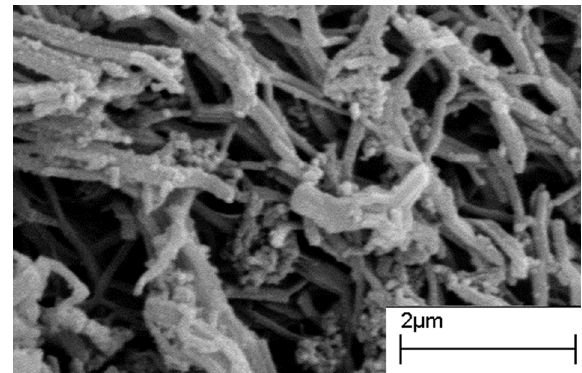
Figure 2. Morphological structure (SEM) of LUS-1